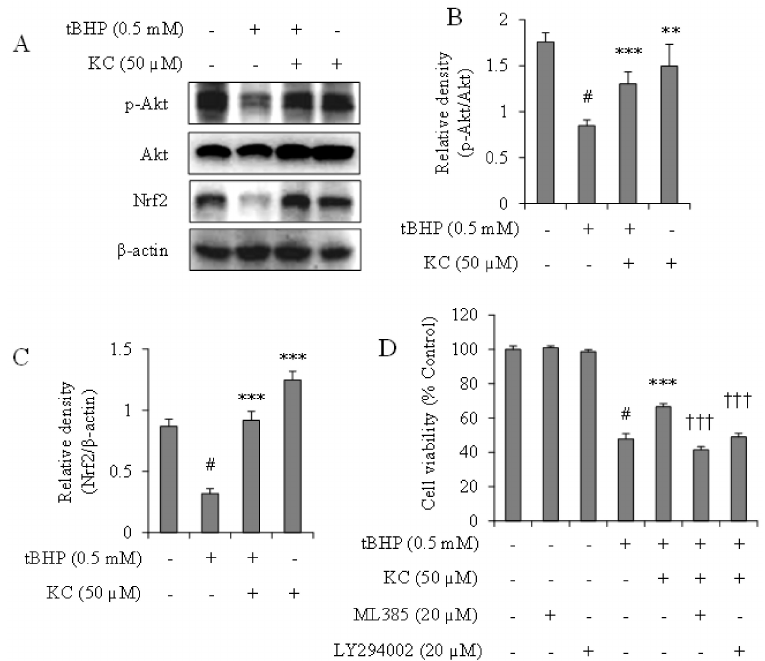
Figure 4. Effect of kushenol C on AKT and Nrf2 expressions in tBHP-treated HEPG2 cells. ( A ) Cells were preincubated with or without KC for 1 h and then treated with or without 0.5 mM of tBHP for 12 h. AKT and Nrf2 protein expression levels were investigated by Western blot assay and the band densities were analyzed using ImageJ analysis software, with respect to actin ( B , C ). ( D ) Cells were preincubated with KC at different concentrations and/or AKT and Nrf2 inhibitors for 1 h and Molecules 2021 , 26 , x FOR PEER REVIEW then treated with tBHP for 12 h. Cell viability was determined using EZ-Cytox reagent. Error bars represent the mean ± SD, # p < 0.001 vs. Control, ** p < 0.01, *** p < 0.001 vs. tBHP-only treated cells, ††† p < 0.001 vs. tBHP plus KC treated cells.